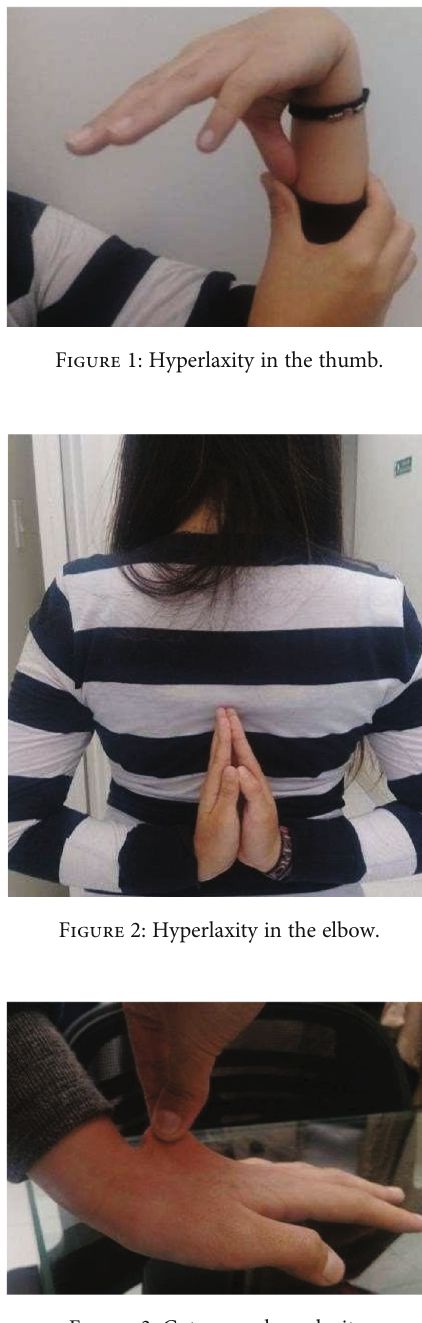
Figure 3: Cutaneous hyperlaxity.